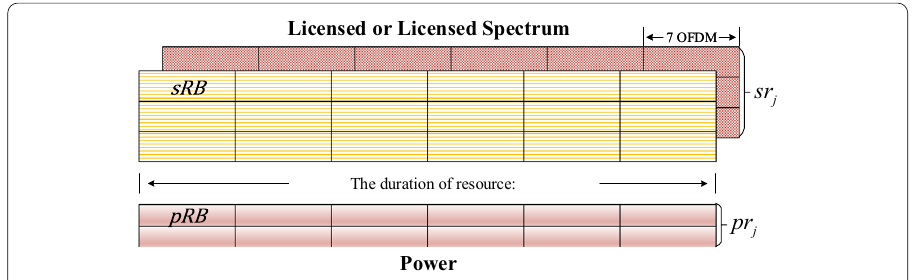
Fig. 3 The resource profile for URLLC data j . The size of the spectrum and power resources required for URLLC data j . The sRB and pRB represent a spectrum RB and a power RB, respectively. The length of an sRB or pRB is 7 OFDM symbols. The total spectrum resource length required for URLLC data is L j , and the width is sr j . The length of the total power resource required for URLLC data is L j , and the width is pr